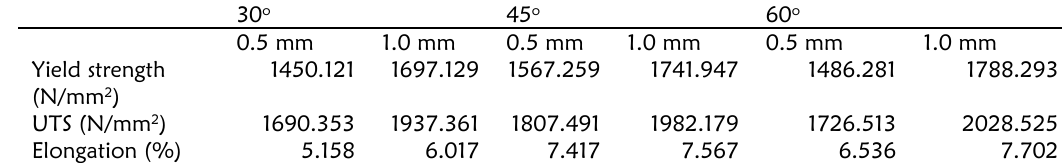
Table 4: Tensile test result for AISI 304 steel (Stainless Steel)